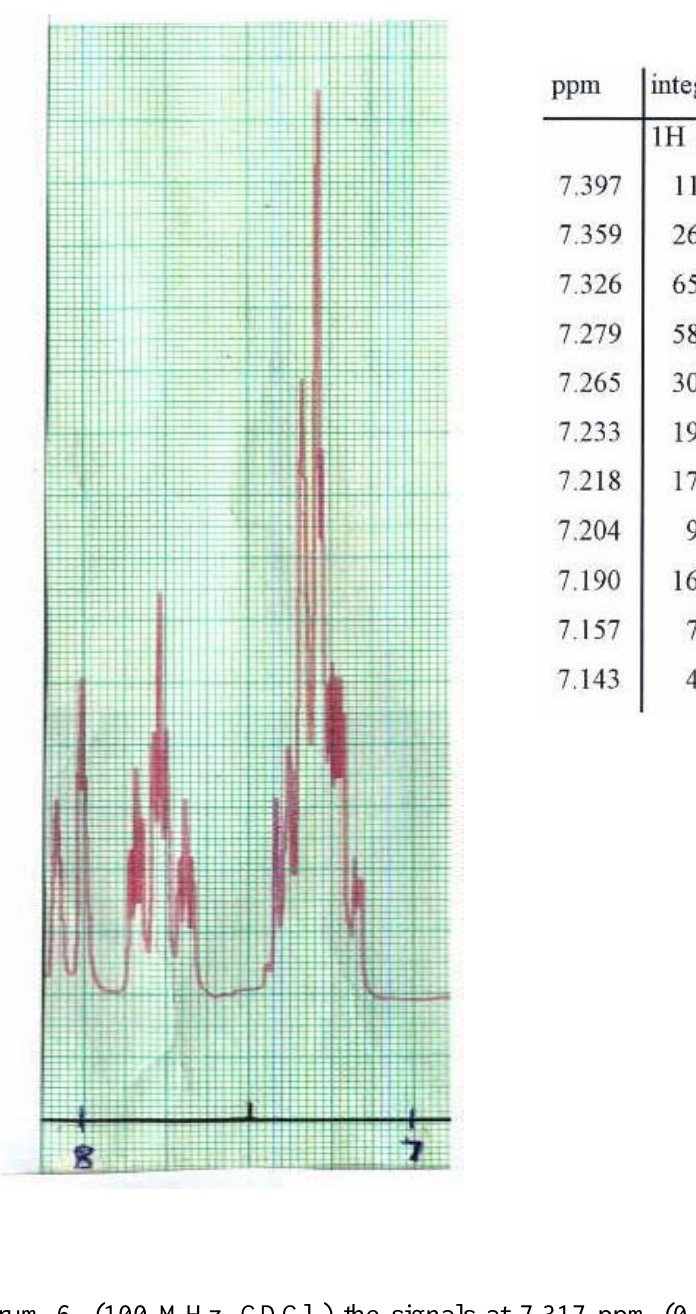
Figure 14 . The 1 H-NMR NH group signal at 7.397 ppm – 7.143 ppm (spectrum